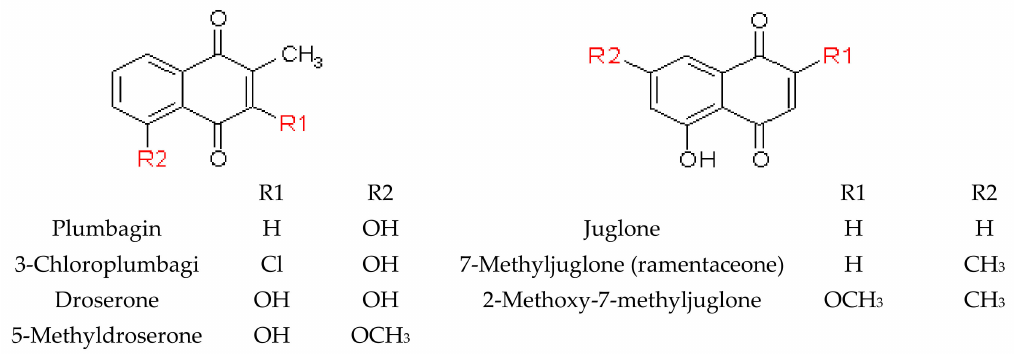
Figure 5. Structure of the most common 1,4-naphthoquinone derivatives identified in Nepenthaceae and